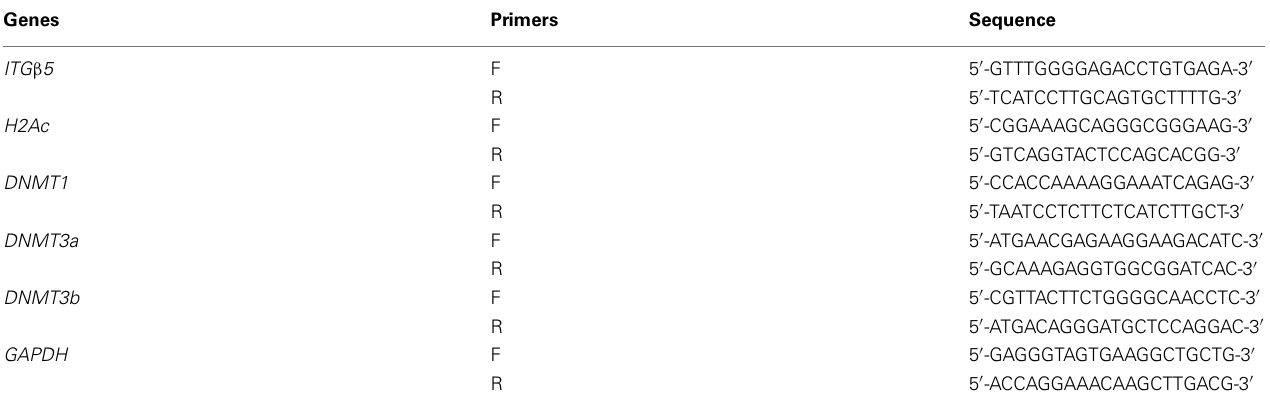
TableA2 | Primers for quantitative real-time RT-PCR.